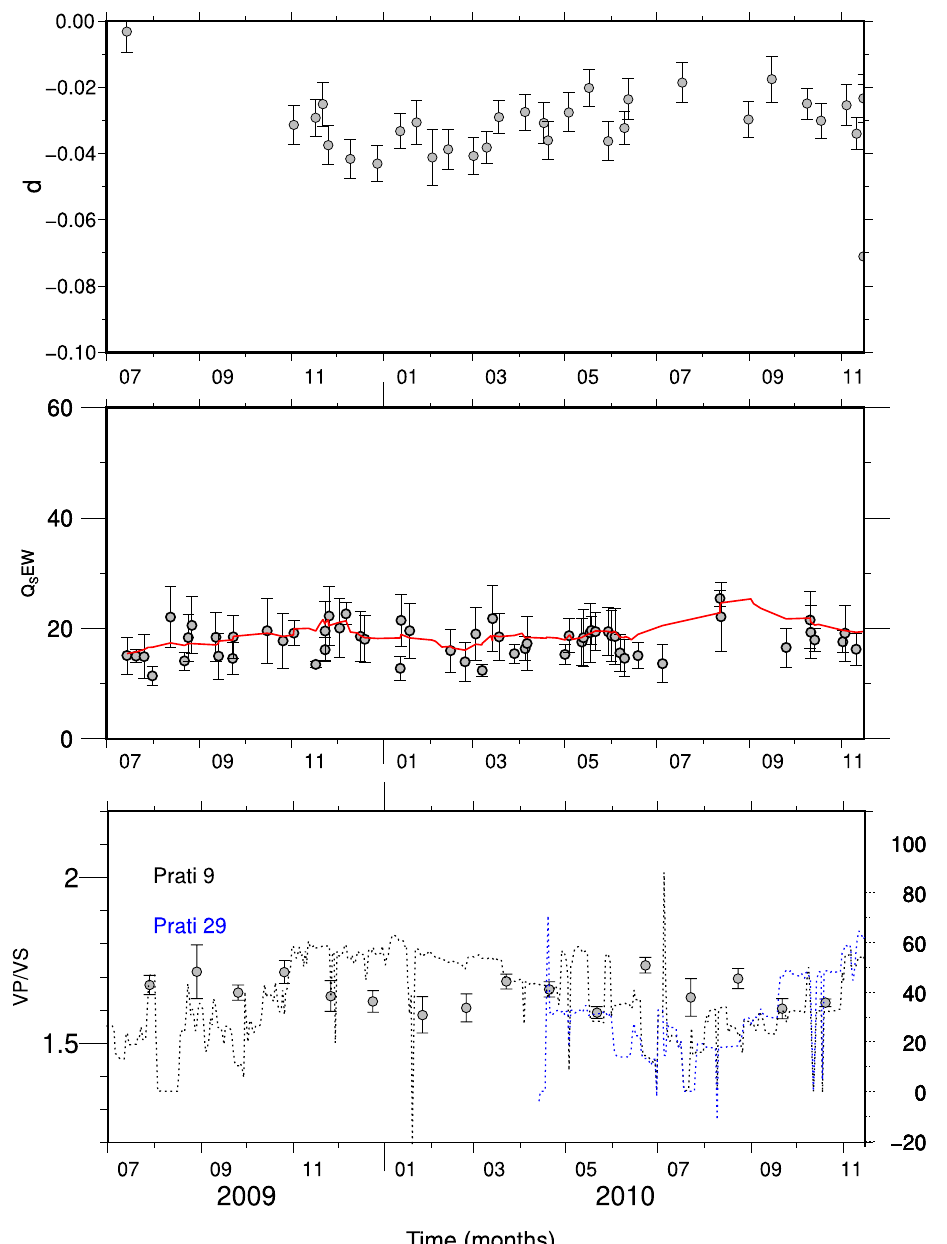
Figure 5. Time evolution of the inferred parameters. Upper panel: the d coefficient and related uncertainty obtained for The Geysers geothermal field. Central panel: Q S quality factor estimated from the spectral analysis for each single earthquake. The red line is obtained by smoothing the single points. Lower panel: V P /V S -ratios and associated uncertainties obtained from the Wadati modified diagram. In the lower panel, the dashed line indicates the daily injection rate at Prati 9 well (black dashed line) and at Prati 29 well (blue dashed